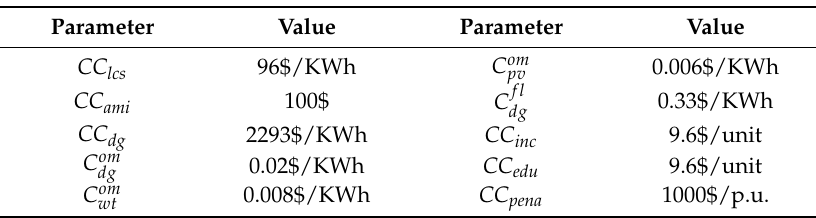
Table 2. Parameters for corresponding costs.